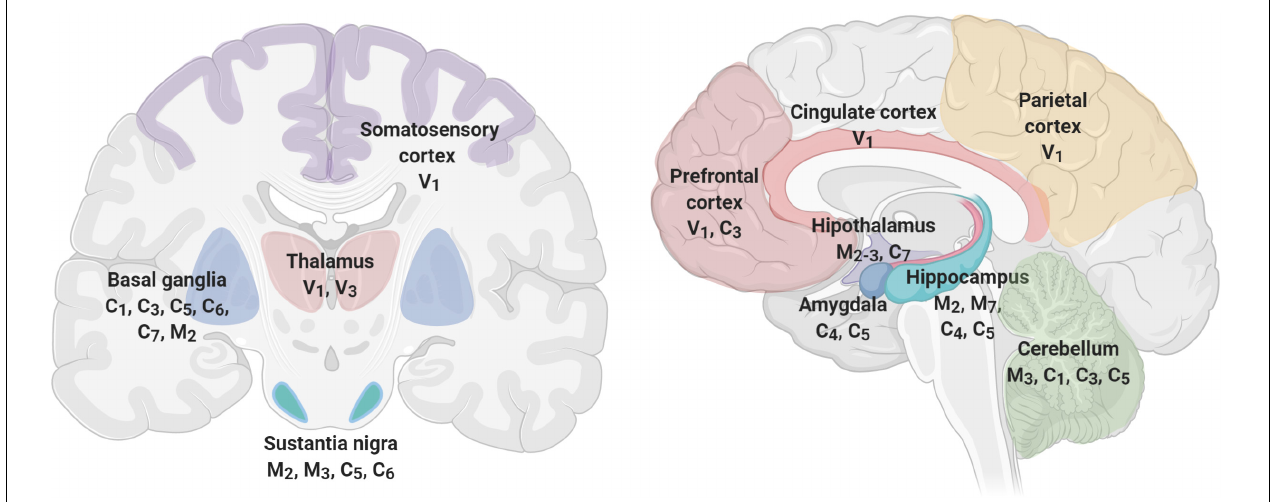
FIGURE 4 | TRP channels are expressed in brain structures involved in pain perception. Pain processing includes cortical (prefrontal, parietal, somatosensory, and cingulate), limbic (amygdala, hippocampus, thalamus, hypothalamus), and movement-related structures (Basal Ganglia, Substantia Nigra, and Cerebellum) that express several members of the TRP channels. TRP families are represented by capital letters as follow, C, TRPC; M, TRPM; V, TRPV; A, TRPA. Numbers indicates specific members of each family.